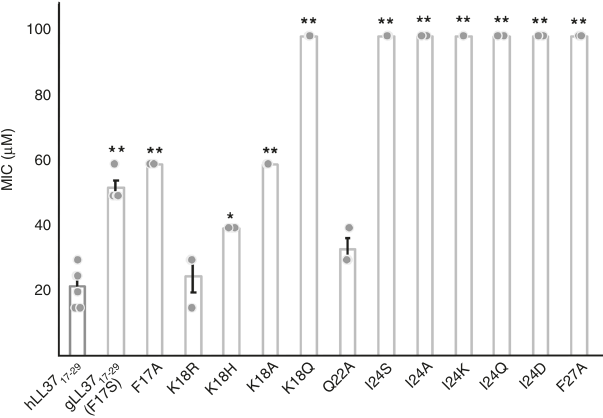
Fig. 1 The effect of LL-37 17-29 and its mutants on the growth of M. luteus . hLL-37 17-29 and single-point mutants were incubated with M. luteus for 24h at a range of concentrations up to 100 µ M, and bacterial growth rate was measured by optical density. From the resulting growth curves, the area under the curve (AUC) was calculated. MIC values were de fi ned as the minimal concentration of the peptide which yielded less than 20% of the AUC of the control (bacteria with no added peptides). The mean MIC value of hLL-37 17-29 is 22 µ M. Mean MIC values of the F17A and K18A mutants, substituting residues lining the central pore, are 60 µ M. Similarly, the mean MIC value gLL-37 17-29 (equivalent to an F17S mutation) is 53 µ M. The K18R, K18H and K18Q mutants showed mean MIC values of 25, 40, and >100 µ M, respectively. The Q22A mutation, substituting a residue showing minimal contacts with other residues within the fi brillar assembly, showed a mean MIC value of 33 µ M. The I24A, I24S, I24K, I24D and I24Q mutations, substituting a residue fully buried in the four-helix bundle, showed a mean MIC value of >100 µ M. The F27A mutation, substituting a buried residue contacting other residues within the four-helix bundle and on surrounding helices in the fi brillar assembly, showed a mean MIC value of >100 µ M. The experiments were performed at least three times, each on different days. Dots display measured values of individual repeats. Error bars indicate the standard error calculated between all measures. A t -test for two-sample assuming equal variances was performed, asterisk indicates p < 5 × 10 − 03 and double asterisk indicates p < 5 × 10 − 05 , compared to hLL-37 17-29 . Source data are provided as a Source data fi